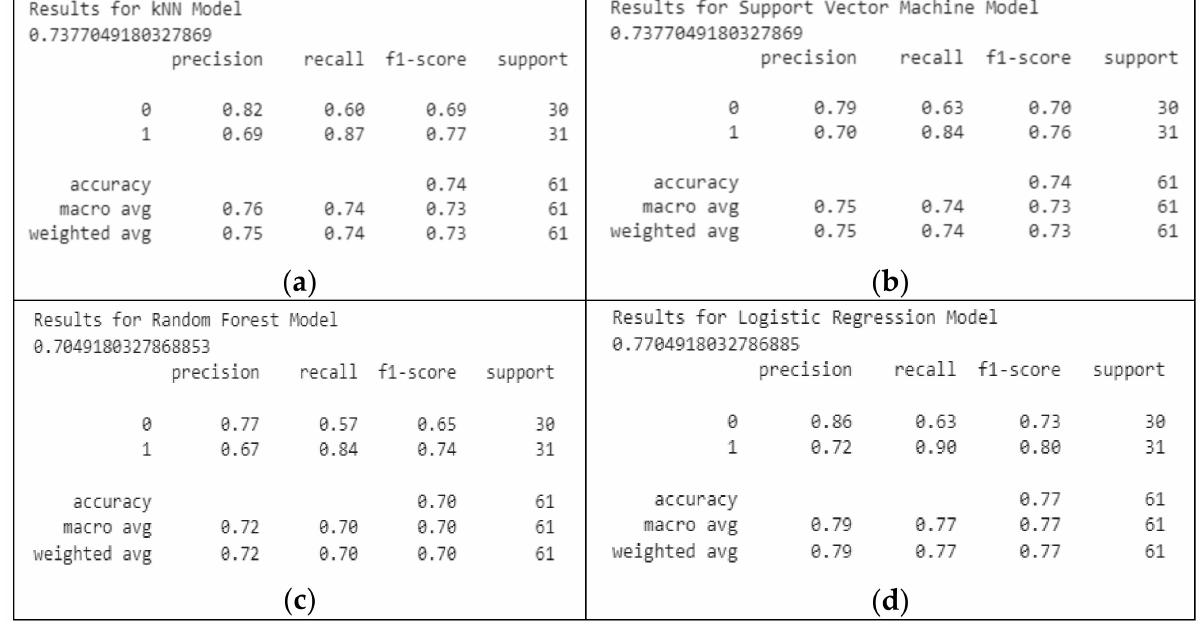
Figure 6. The classification reports for the ML algorithm: ( a ) classification report for kNN model; ( b ) classification report for SVM model; ( c ) classification report for random forest model; ( d ) classifi- cation report for logistic regression model.